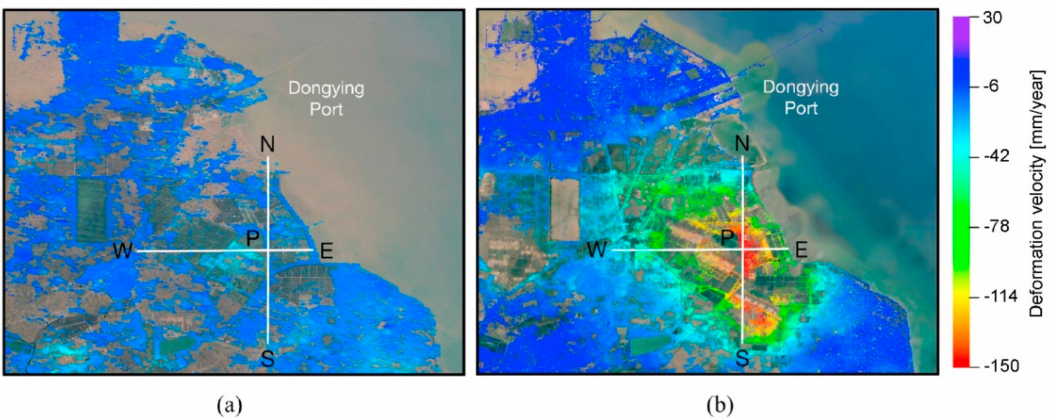
Figure 18. Vertical subsidence velocity map near Dongying Port in the Yellow River Delta, China, for the periods of ( a ) 2007–2010 and ( b ) 2015–2018. (Adapted with permission from